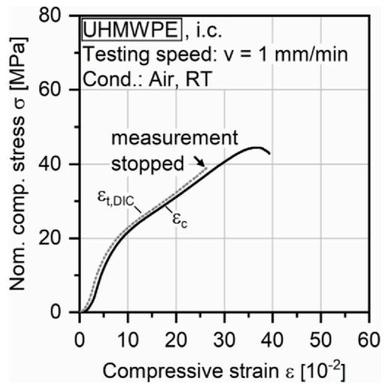
Result of quasi-static compression test on UHMWPE in air at room temperature (RT), instrumented with digital image correlation (DIC).